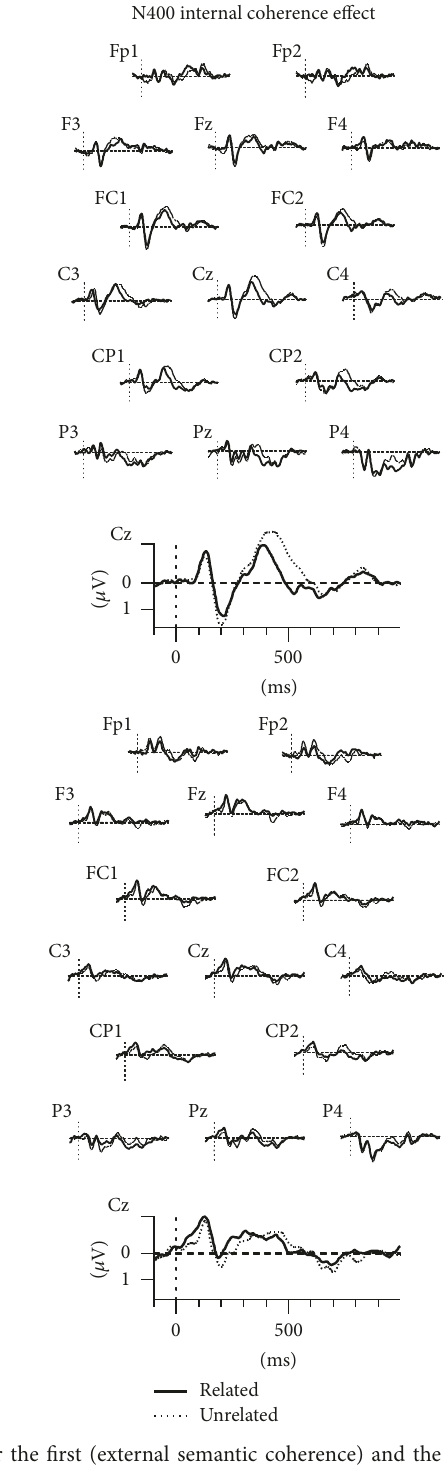
Figure 3: Grand average ERPs at fifteen representative electrode sites for the first (external semantic coherence) and the second words (internal semantic coherence) of word pairs in related versus unrelated conditions during the study phase in healthy controls and schizophrenia